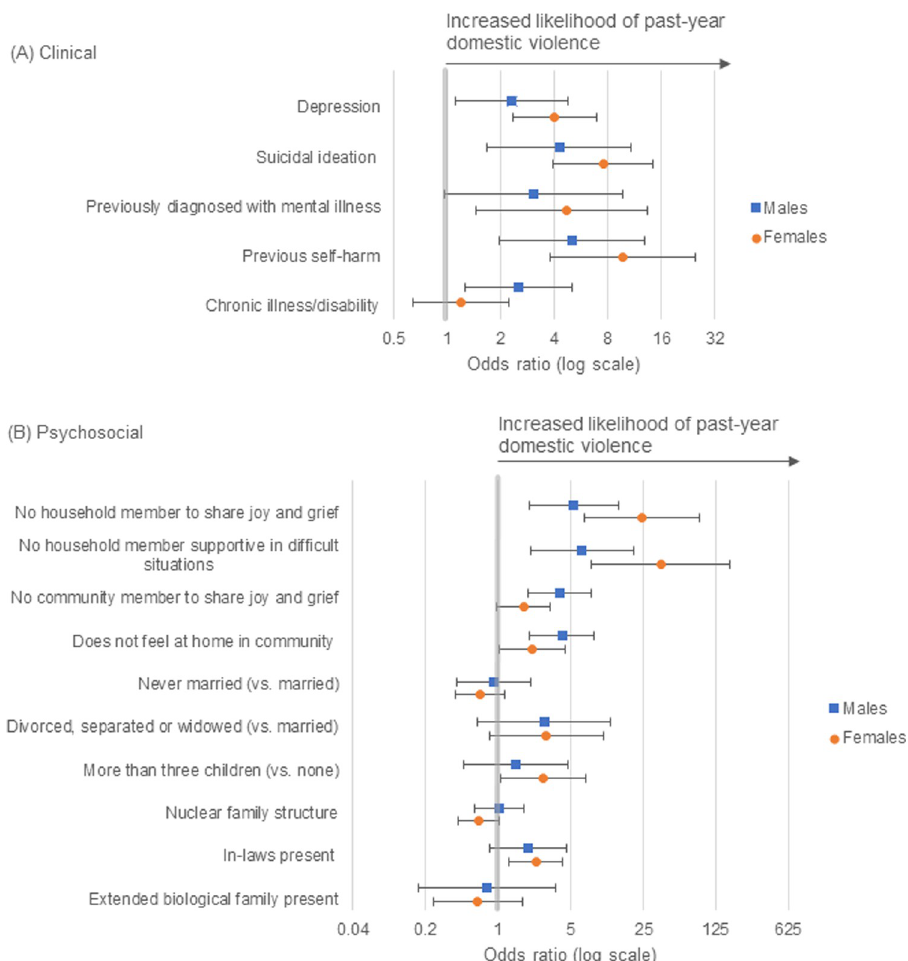
Fig 2. Clinical and psychosocial factors associated with past-year domestic violence by sex, Kandy, Sri Lanka. (A) Clinical correlates of past-year domestic violence, adjusted for age. (B) Psychosocial correlates of past-year domestic violence, adjusted for age and ethnicity. The bold line indicates a null